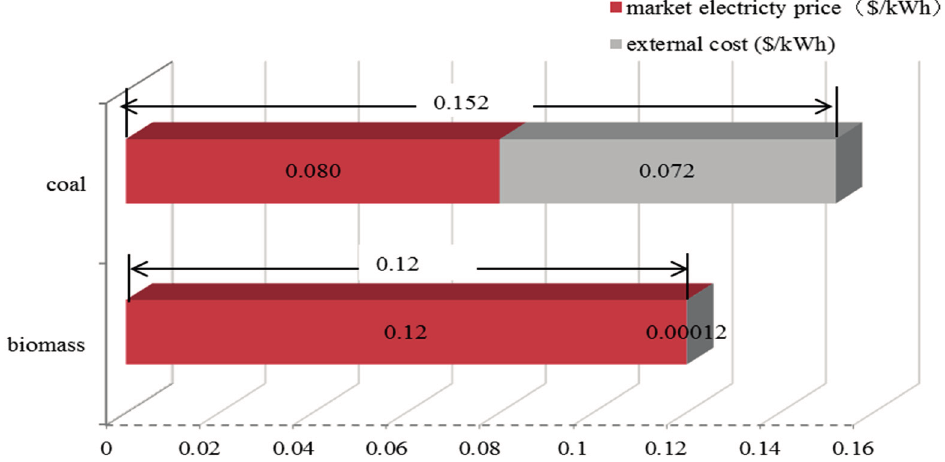
Figure 7. Comparison of external costs and total lifecycle cost of biomass power generation and coal-fired power